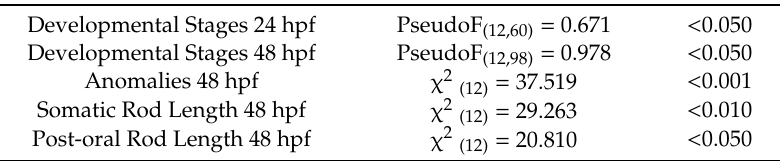
Table 1. PERMANOVA results, with PseudoF values and p -values, for developmental stages at both 24 and 48 hpf and the linear mixed model (LMM) results, with Chi-square values and p -values, for the frequency of anomalies and rod lengths at 48 hpf in larvae exposed to the various concentrations of glyphosate, AMPA and